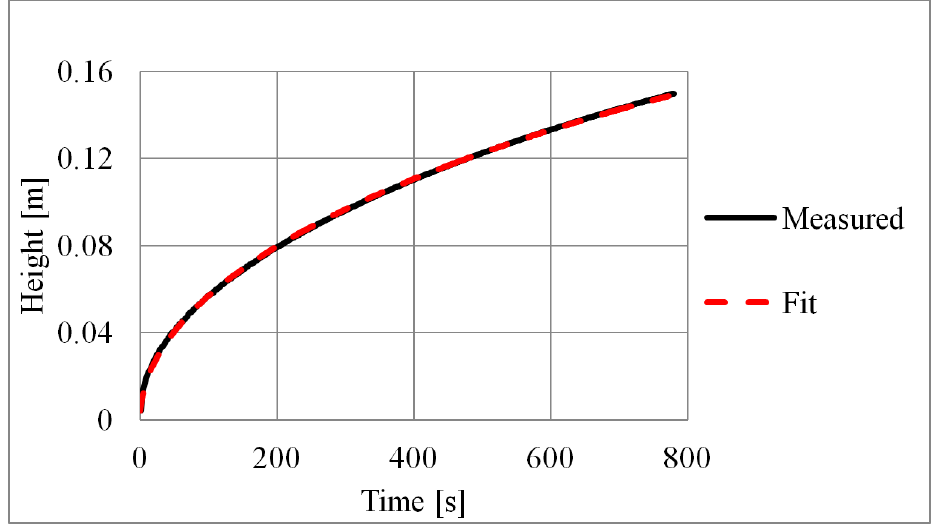
Figure 8. Rate-of-rise data for the wick produced by tape